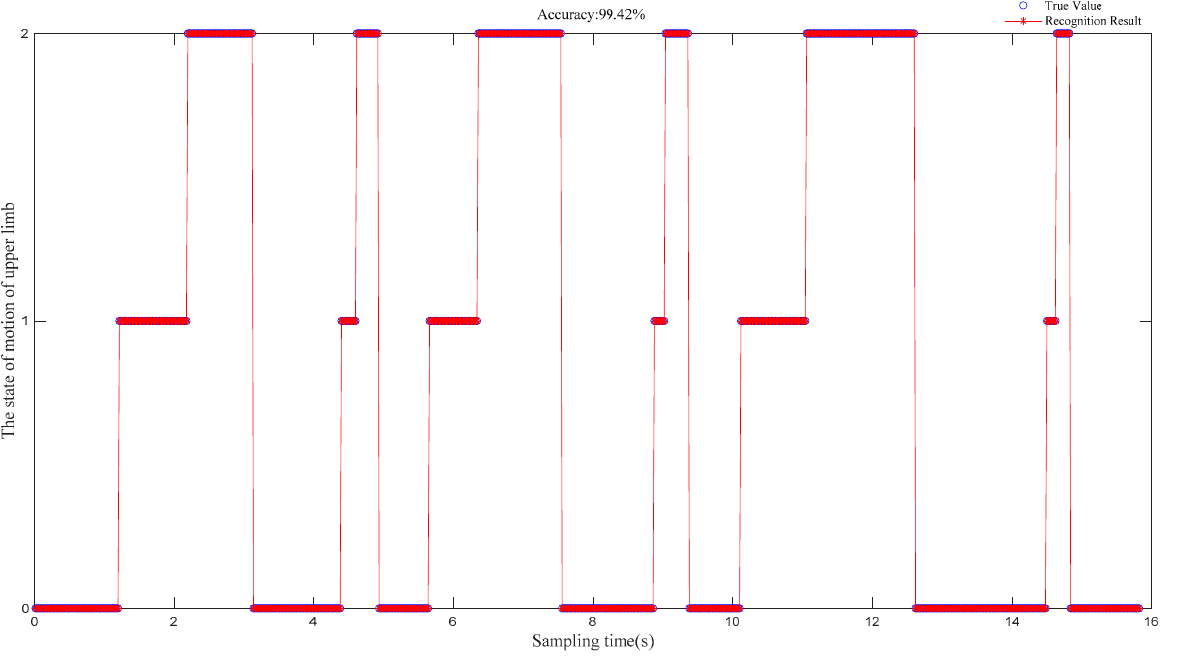
Figure 6. The recognition result of the action of putting on socks.